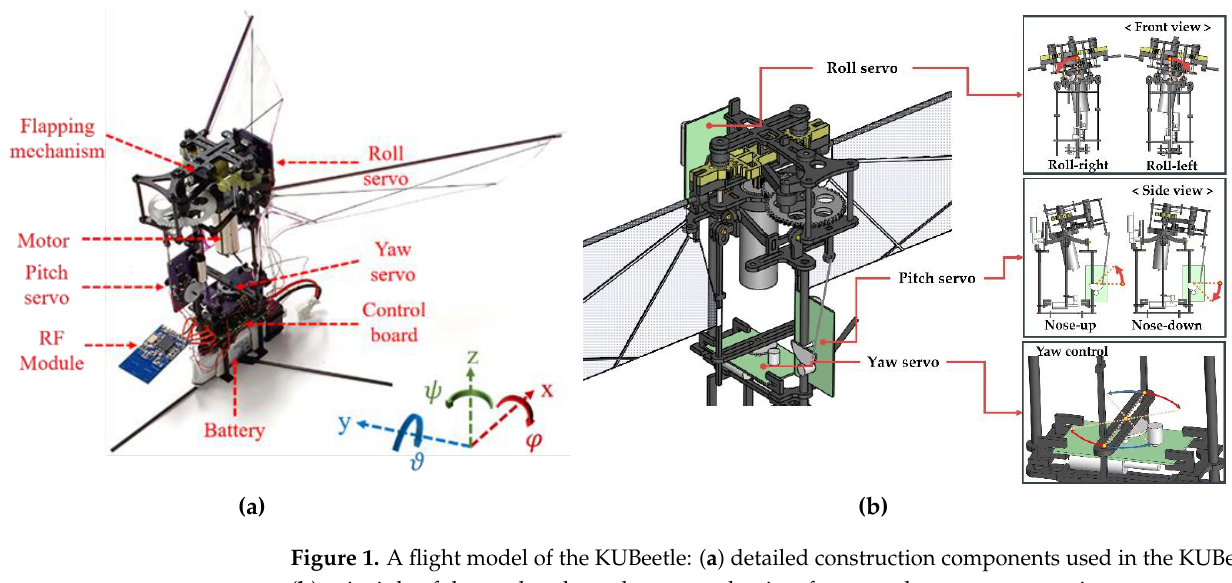
Figure 1. A flight model of the KUBeetle: ( a ) detailed construction components used in the KUBeetle; ( b ) principle of the stroke-plane-change mechanism for control moment generation.